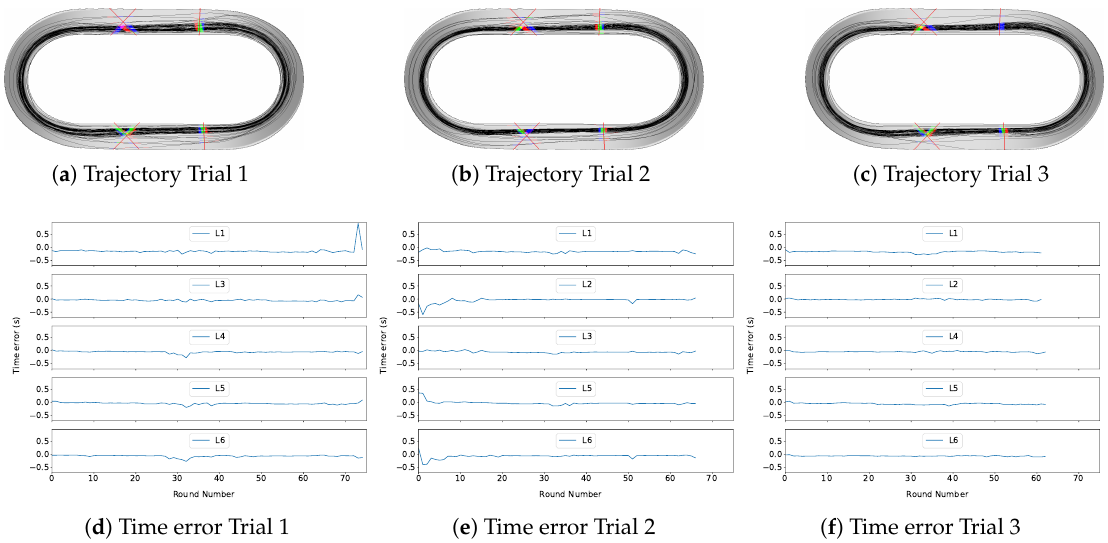
Figure 6. ( a – c ) Trajectory of a biker in all trials after 100 iterations. The lasers are shown as red lines. Blue color means that the estimator predicts that the bike passes a laser barrier. Red color means that a barrier measured that a bikes passes. Green color shows where prediction and measurement